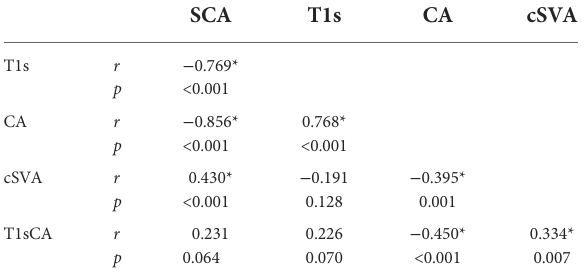
TABLE 4 Pearson correlations of preoperative cervical sagittal parameters.